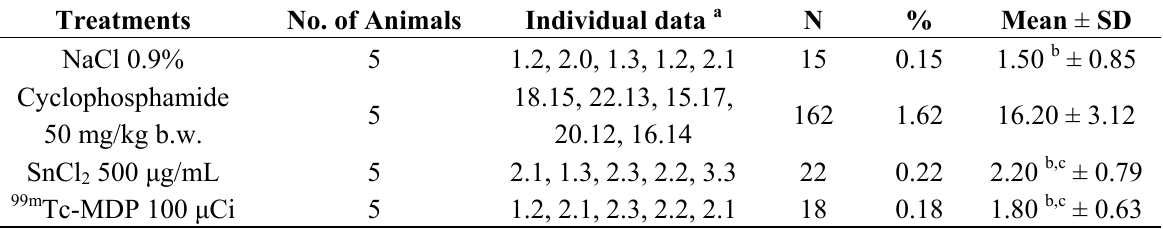
Table 1. Micronucleus Test in Wistar rats bone marrow. Micronucleated polychromatic erythrocytes Treatments No. of